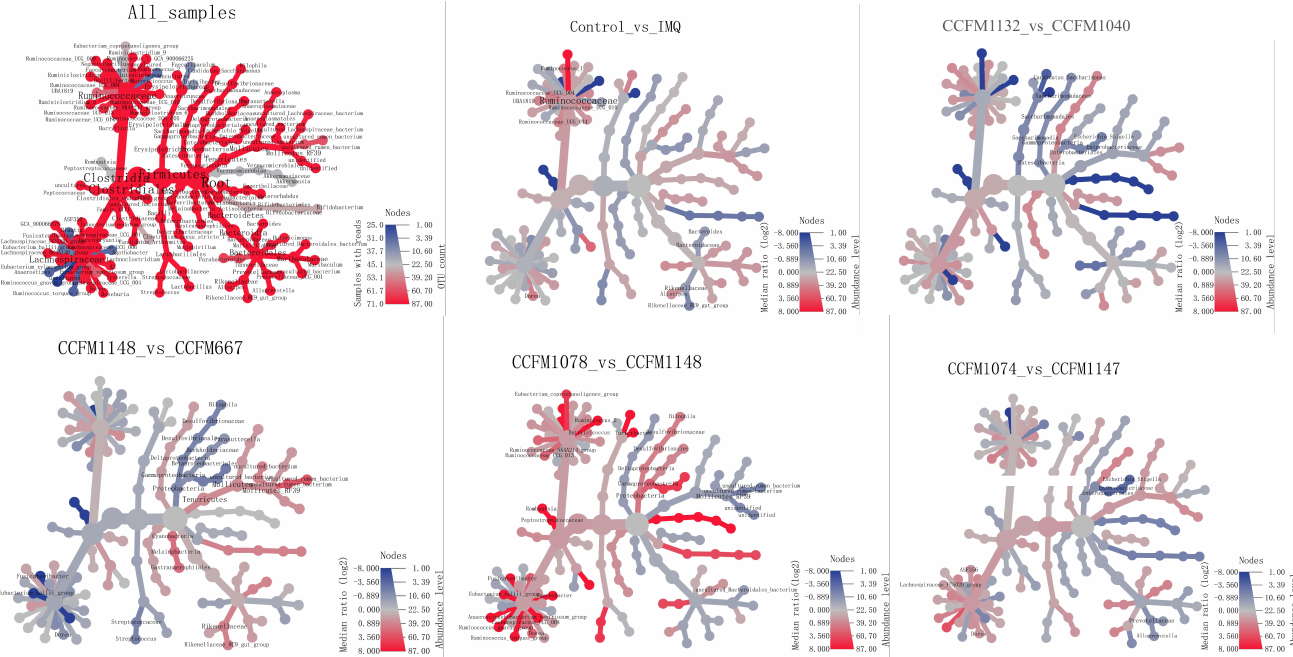
Figure 8. Heat tree analysis of gut microbiota at the genus level ( n = 5/6). Nodes marked with text represent a significance difference between the two groups, p <